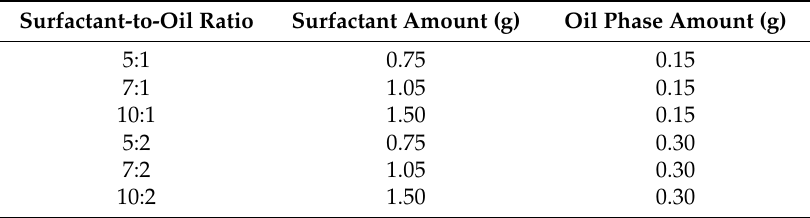
Table 1. The composition of lidocaine nanoemulsions